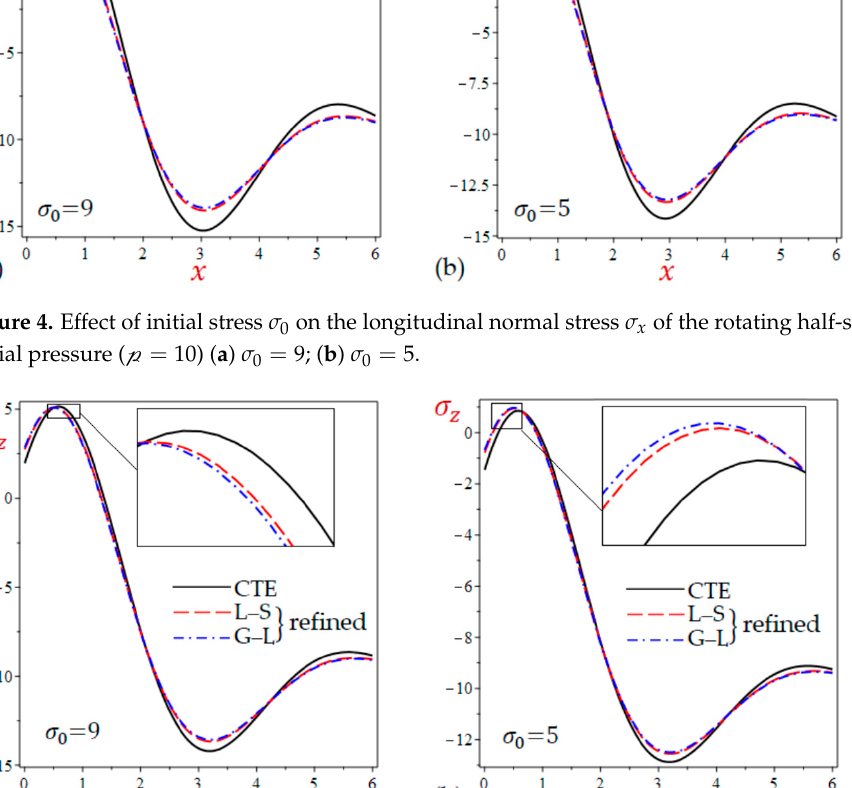
Figure 6. Effect of initial stress 𝜎 (cid:2868) on the transverse shear stress 𝜎 (cid:3051)(cid:3053) of the rotating half-space with initial pressure ( 𝓅 = 10 ) ( a ) 𝜎 (cid:2868) = 9 ; ( b ) 𝜎 (cid:2868) = 5 .